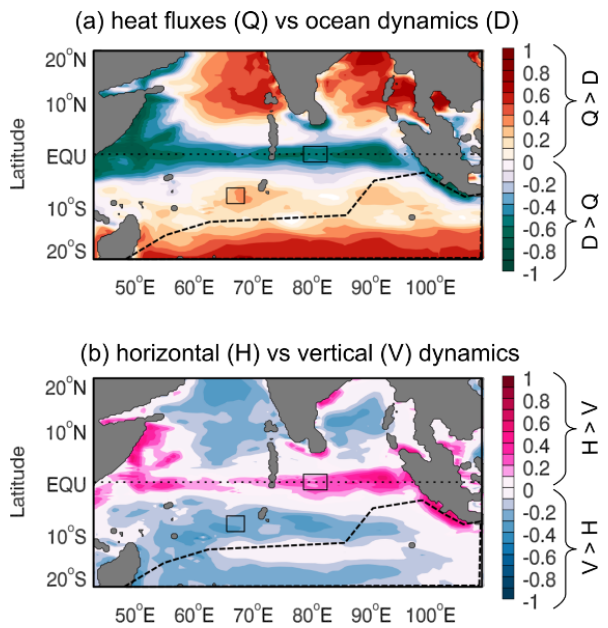
Figure 7. Modelled balance of processes driving intraseasonal SST variability. (a) Relative role of heat fluxes ( Q ) and ocean dynamics ( D ) in driving SST variability, with red (green) colours implying Q ( D ) dominates forcing. (b) Relative role of horizontal (H) and vertical (V) processes in the dynamical forcing, with pink (blue) colours implying that H (V) processes dominate. All fields are de- rived from the ECCO-JPL ocean state estimate. The dotted line marks the Equator, the dashed line in the Southern Hemisphere out- lines a region in which the model does not fully resolve the ocean heat budget, and the boxes on the Equator and at 10 ◦ S mark regions for further analysis not described here. Modified from Halkides et al.